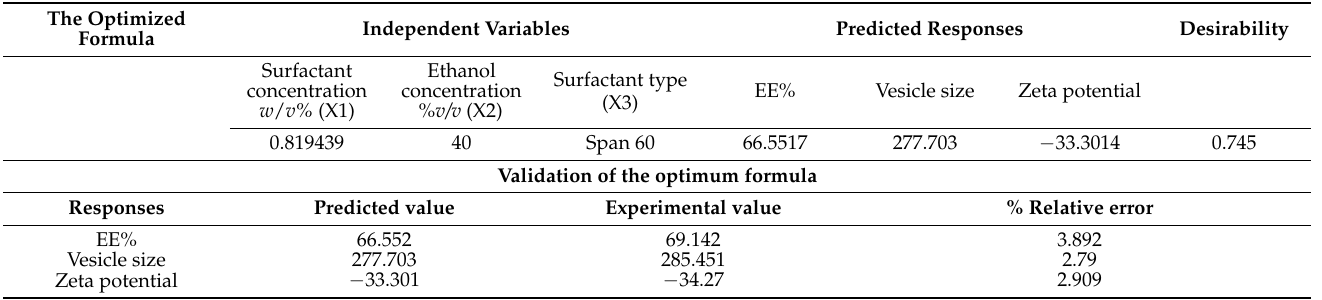
Table 5. The composition and validation of the optimized formula with its predicted responses according to I optimal